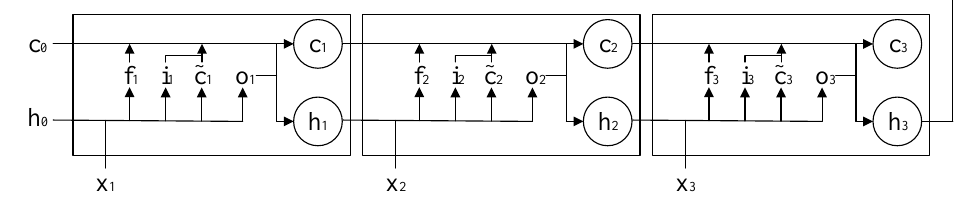
Figure 4. The structure of LSTM units with three nodes.